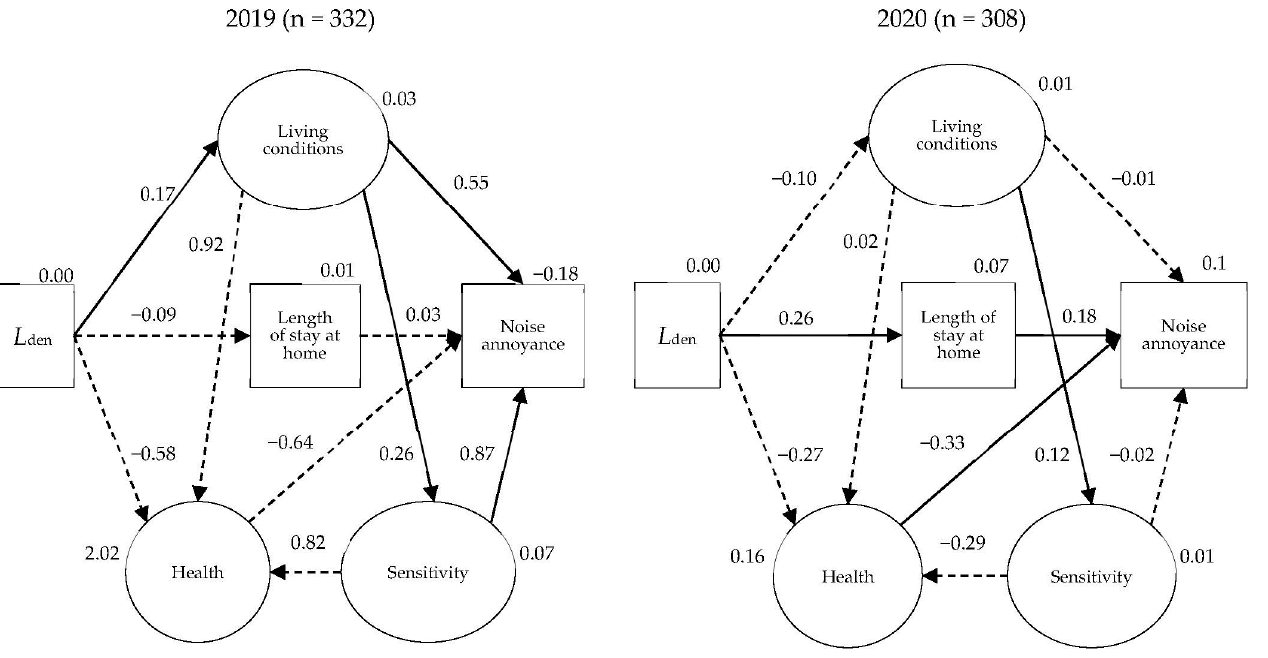
Figure 4. Structural equation model estimated for noise annoyance with length of time at home variable in the 2019 and 2020 surveys using chi-square, GFI, CFI, and RMSEA statistics: chi-square = 269.964, p < 0.01, df = 74, GFI = 0.935, CFI = 0.826, and RMSEA = 0.064. Statistically signi fi cant paths and standardized regression weights were annotated with ( p < 0.05). The non-signi fi cant paths are represented by dashed lines. The explained variances are annotated for each variable.